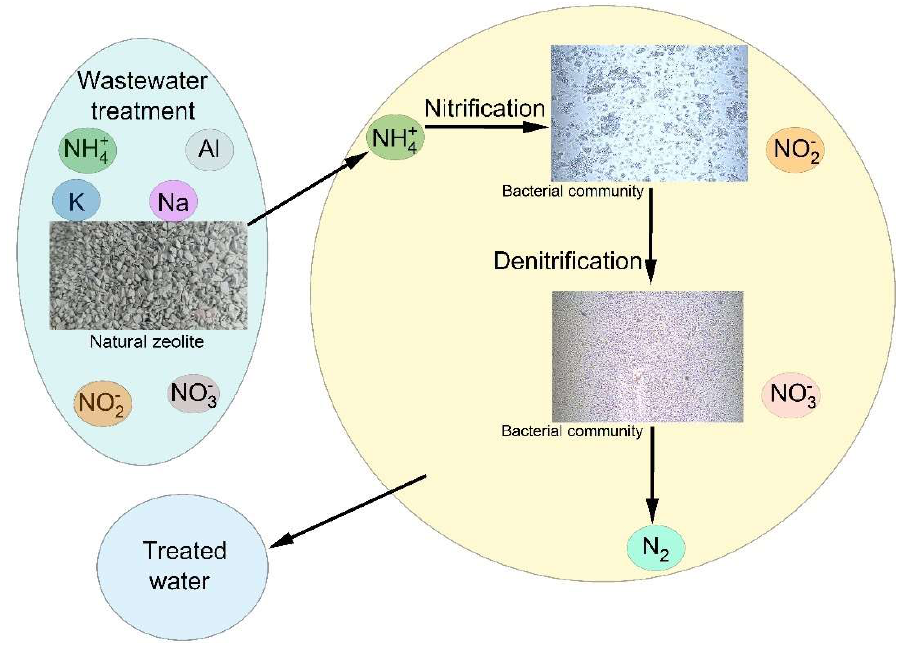
Figure 9. Schematic representation of the mechanism of wastewater treatment .